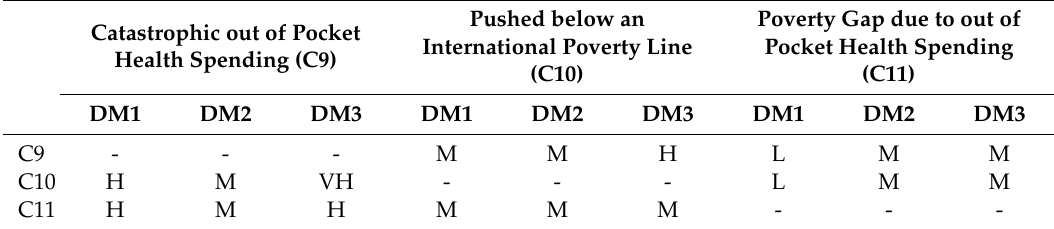
Table 9. Linguistic evaluations of decision makers for the dimension of sustainable economic growth. Growth Rates of Household Annual Growth Rate of Real Annual Growth Rate of Real GDP Per Employed Person GDP Per Capita (C12) (C13)